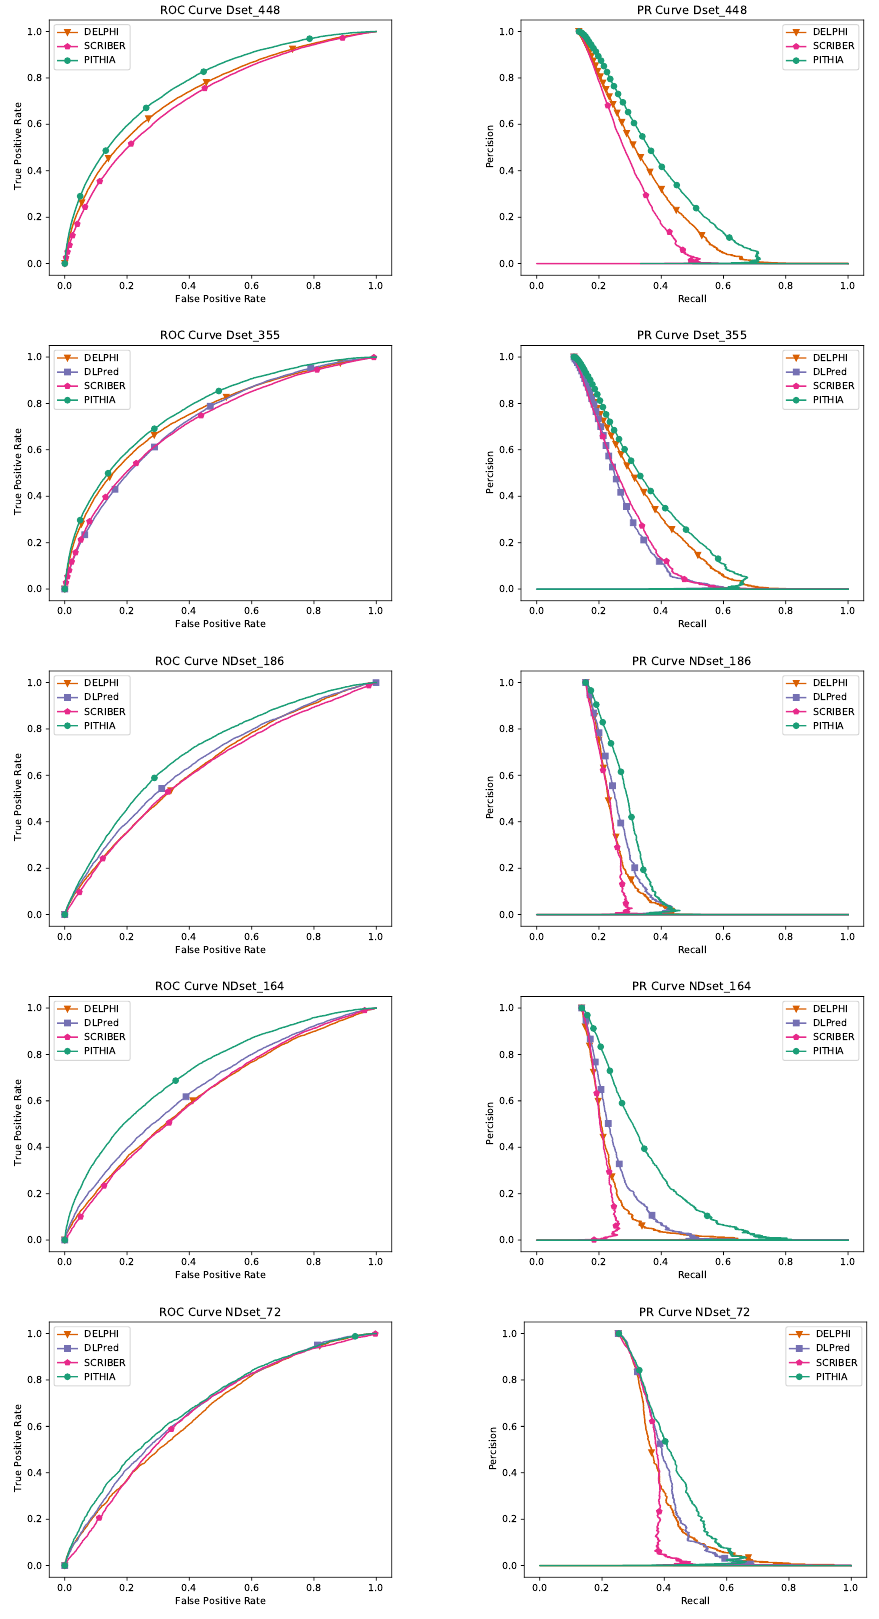
Figure 1. ROC and PR curves for the tests in Table 1, in the same order. The left column contains and ROC curves and the right one the PR curves. The two curves for each test are in the same